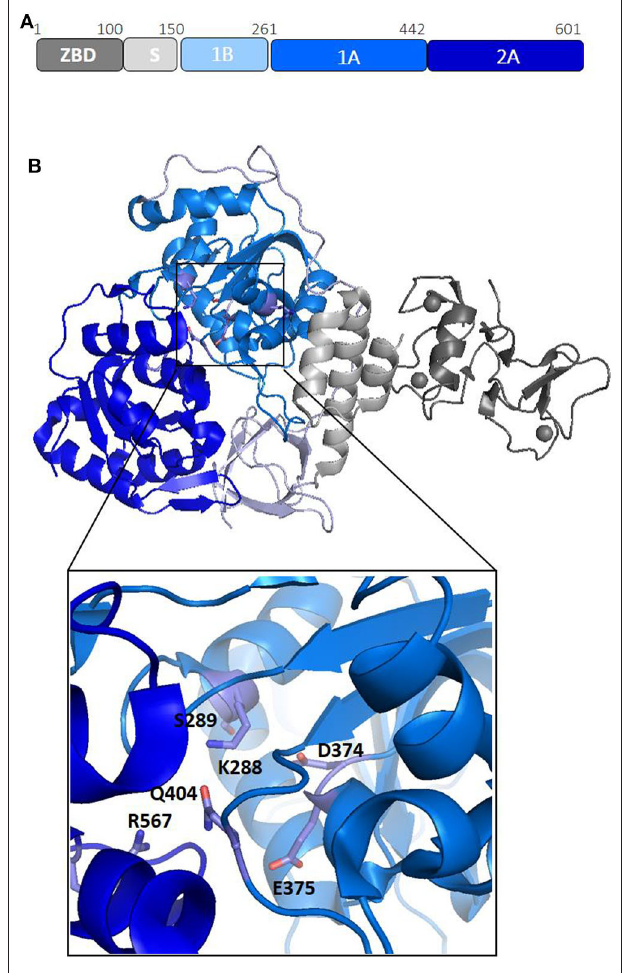
FIGURE 3 | Structural organization of SARS-CoV-2 Nsp13 helicase. (A) Organization of Nsp13 in domains. (B) Cartoon representation of the crystal structure of Nsp13 from SARS-CoV-2 Nsp13 (pdb code 6zsl). The color code, in panel A, is: ZBD-gray, stalk-light gray, 1B-light blue, 1A-blu marine, and 2A-blue. In the inset, the key conserved residues responsible for NTP hydrolysis are drawn as